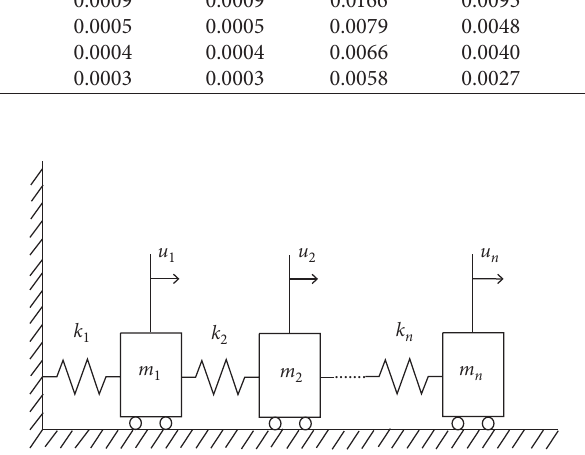
Figure 32: Schematic plot of the n -DOF spring-mass system.